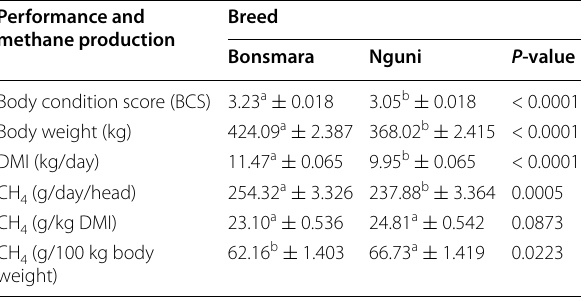
Different letters “a and b” represent significant differences (P breeds Table 4 Means ( SEM) of methane production and other ± performance parameters as affected by grazing system